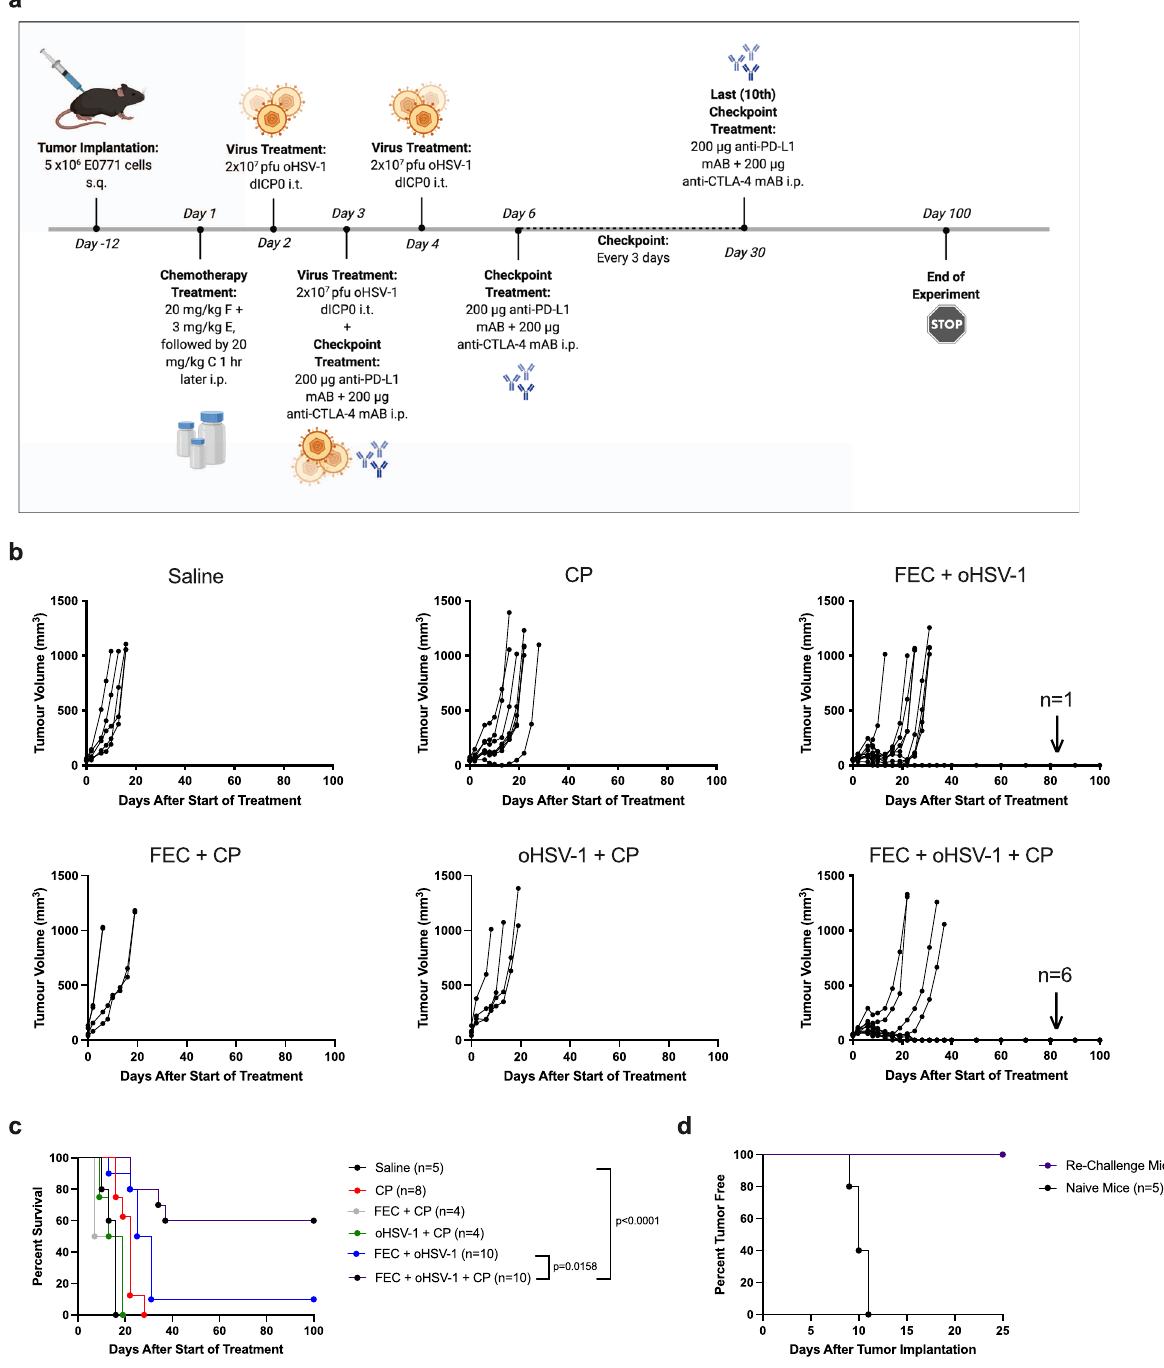
Fig. 2 FEC + oHSV-1 + CP decreases tumor kinetics and results in durable tumor regression in 60% of mice. a C57/Bl6 mice bearing E0771 tumors were treated with saline, CP (anti-CTLA4 and anti-PD-L1), FEC + CP, oHSV-1 + CP, FEC + oHSV-1, or FEC + oHSV-1 + CP. *Created using BioRender.com. b Tumor volumes were measured every 2 – 3 days from the start of treatment until mice reached endpoint. Each line represents an individual mouse within the group. c Kaplan – Meier survival curves of each group. d Mice who achieved durable tumor regression with FEC + oHSV-1 + CP therapy were subsequently re-challenged with E0771 cells on day 63 days. Naïve mice of similar age were used as a control for tumor implantation and growth. *Mantel – Cox test was used for statistical